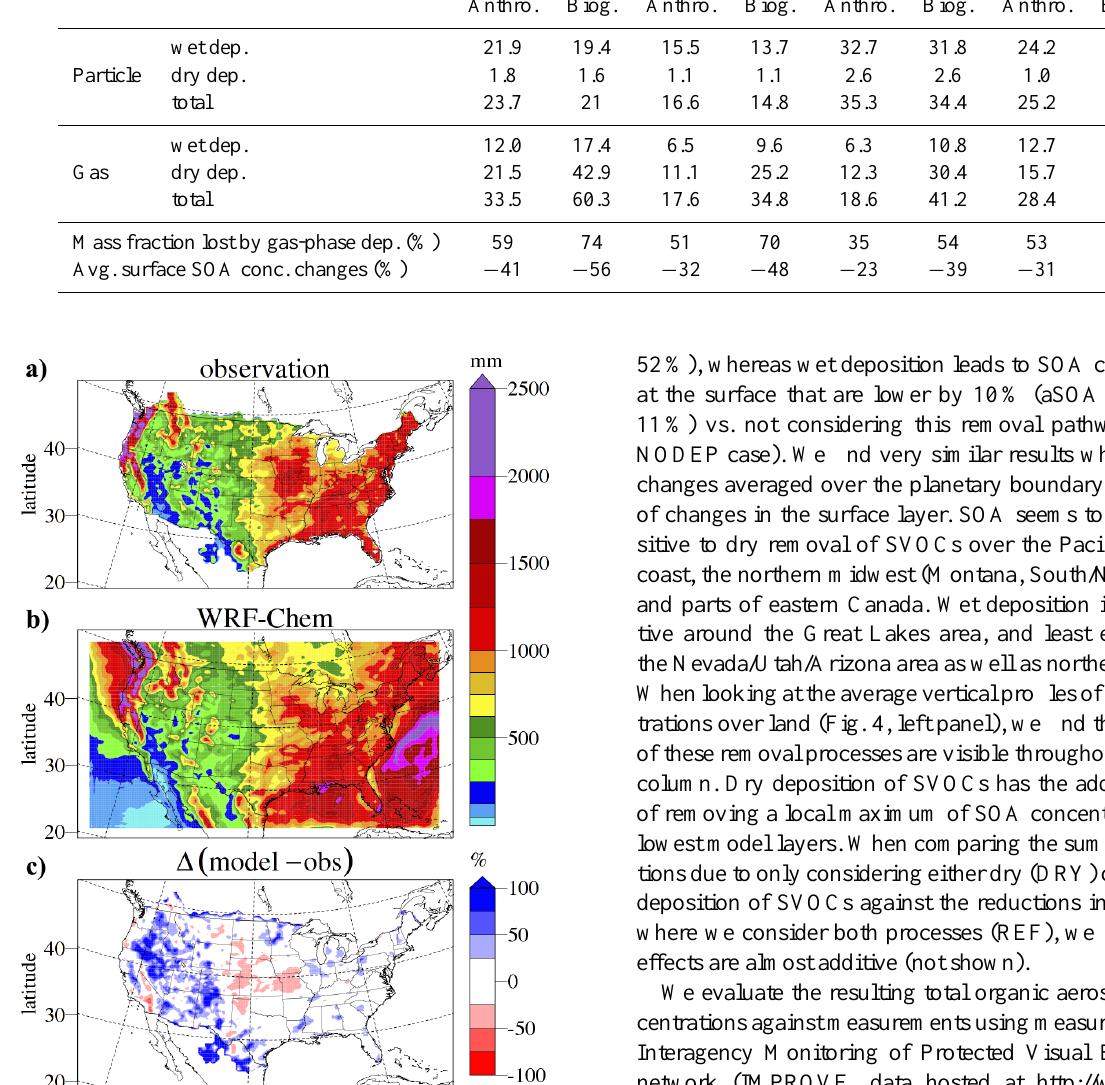
Table 4. Contributions of dry and wet deposition through the gas / particle phase as well as resulting change in surface level SOA concen- trations over the continental US in June, July, and August for selected sensitivity studies. Values in the two lowermost rows are percentual changes (%), all other rows are accumulated deposited mass in Gg. REF LOWVOL FAST_AGING VEGFRA Anthro. Biog. Anthro. Biog. Anthro. Biog. Anthro. Biog.